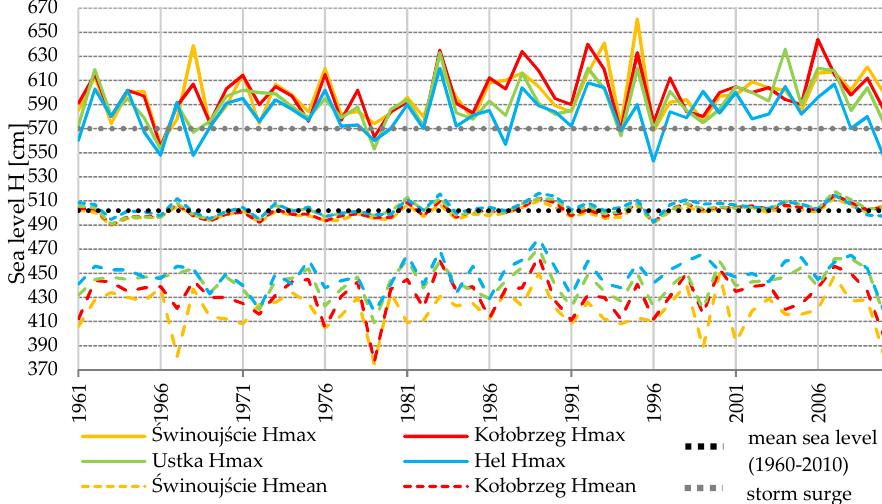
Figure 5. Annual dynamics of sea level in the Polish Baltic coastal zone.